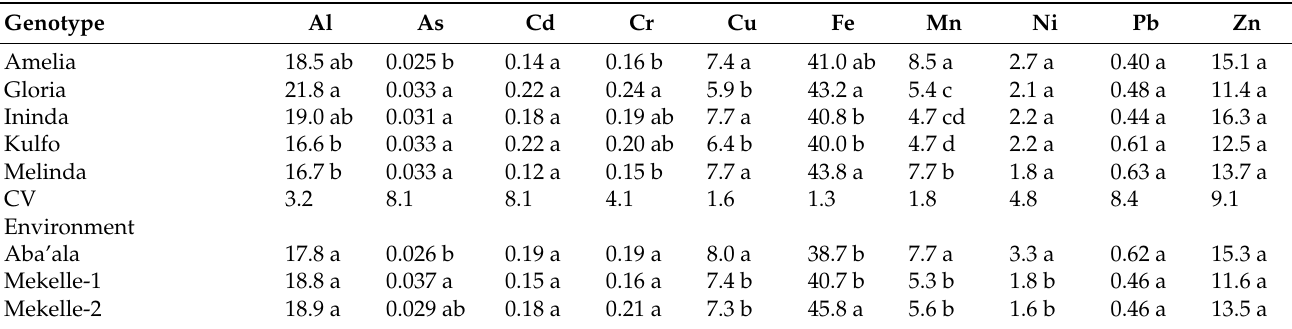
Table 6. Content (mg kg − 1 dw) of potentially toxic elements in sweetpotato genotypes in the studied environments. Different letters indicate statistical differences between the genotypes.